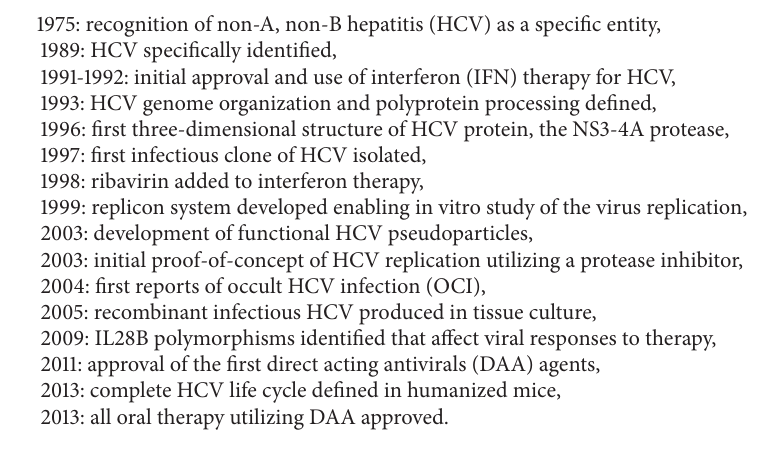
Table 1: Characteristics of occult hepatitis C infection (OCI) + . Evidence of liver